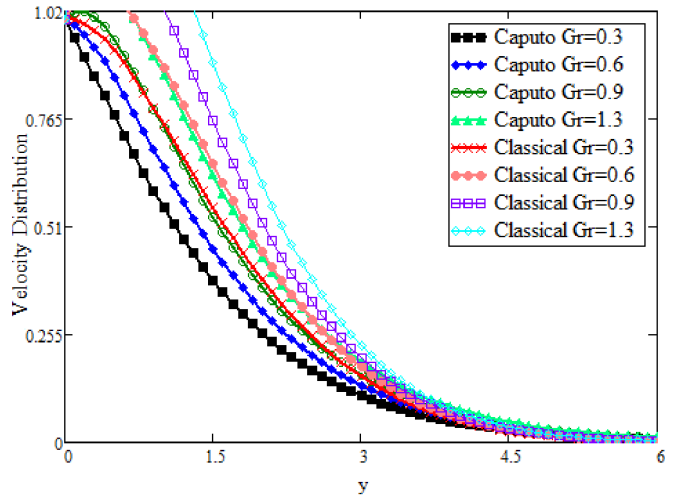
Figure 6. Comparative analysis of velocity distribution for different Gr values.